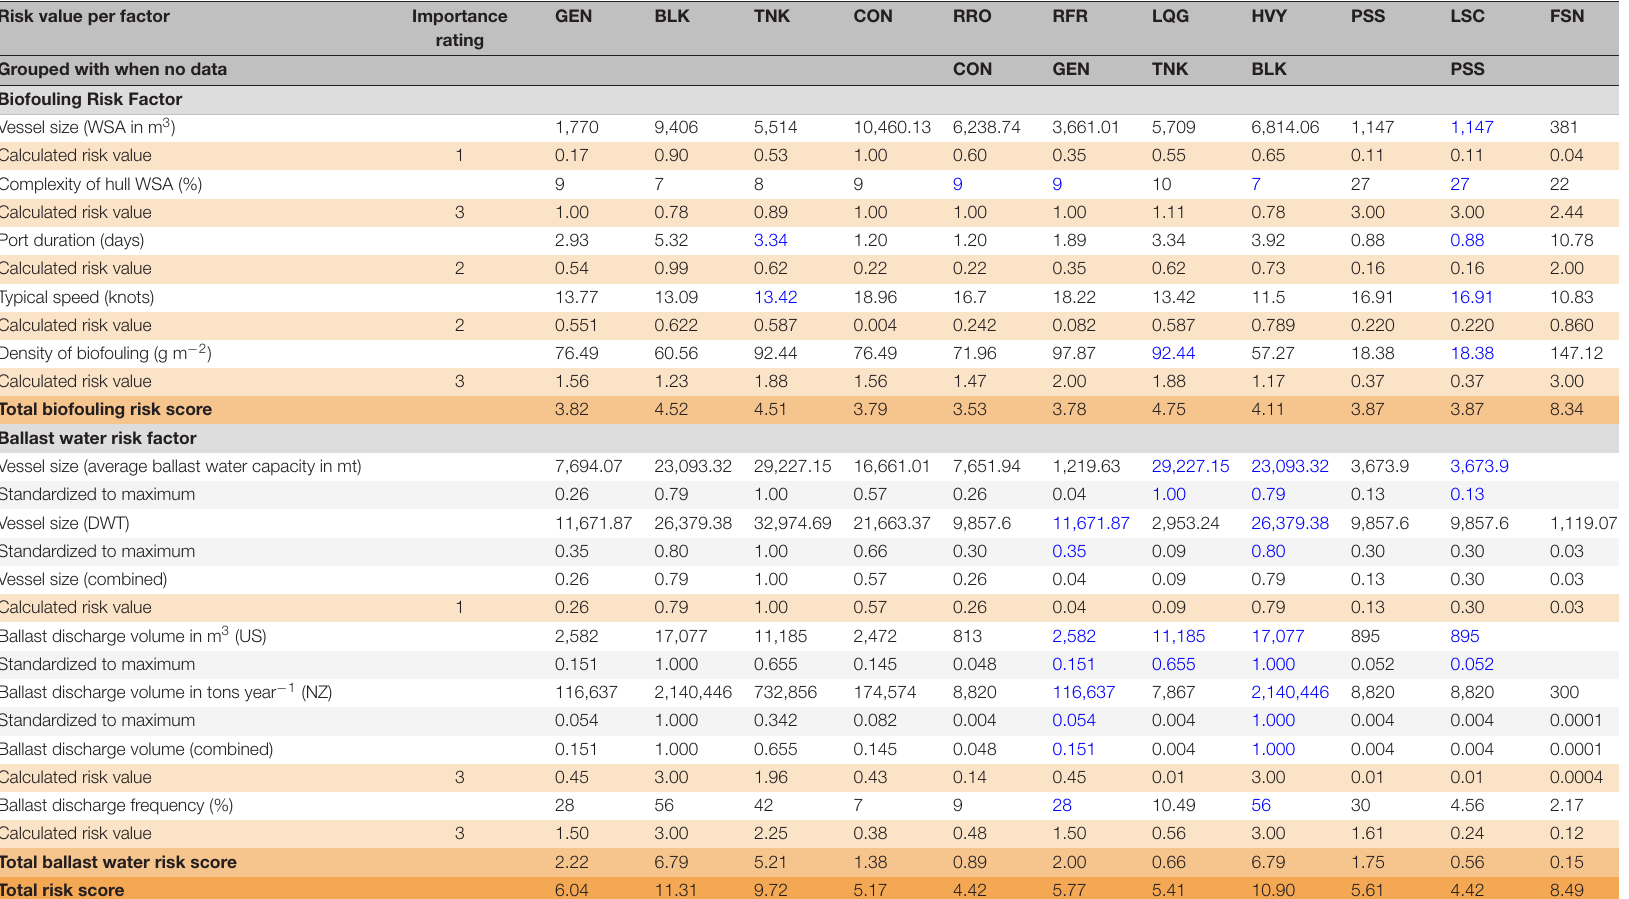
TABLE 4 | Vessel type risk